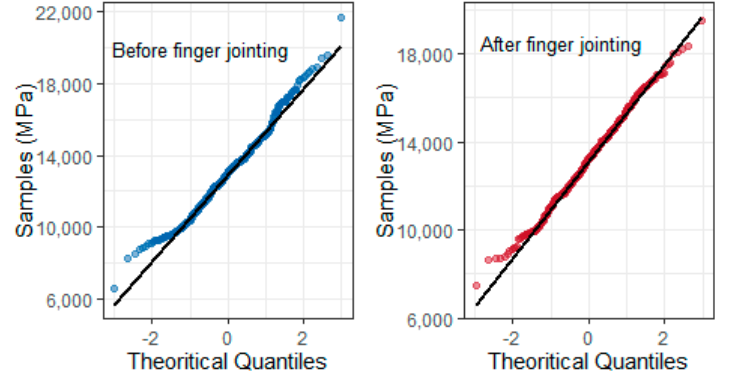
Figure 8. Q-Q plots of flatwise MoE data sets.